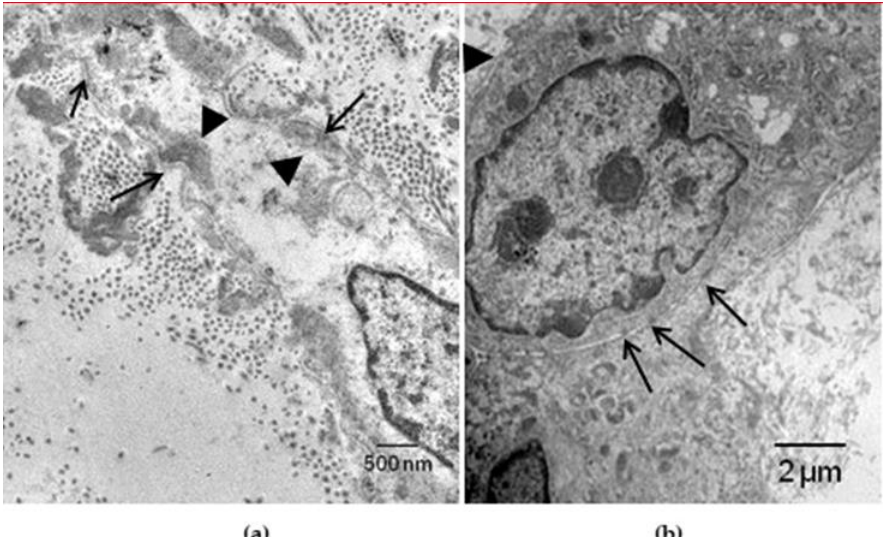
Figure 33. ( a ) Repopulating smooth muscle cells with basal lamina (arrows) and few contractile filaments with focal densities, close to the cytoplasmic membrane and in the paranuclear region (arrowheads). ( b ) Implanted pulmonary homograft cusps: poorly differentiated cells with intercellular junctions (arrows), rough endoplasmic reticulum, and focal basal lamina (arrowhead). From [67].